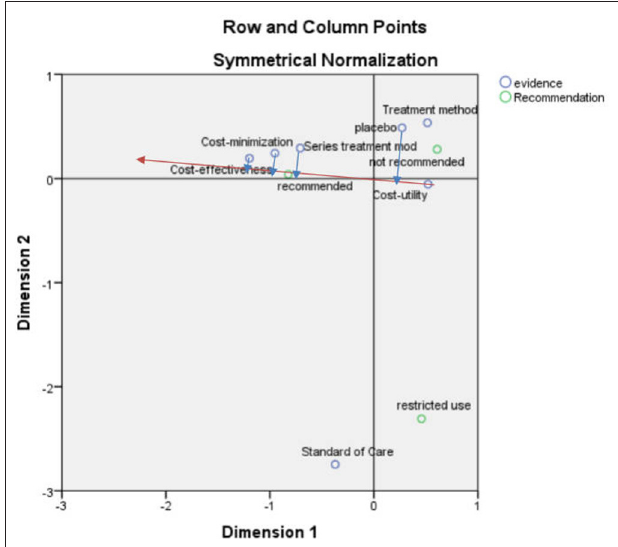
FIGURE 4 | Correspondence analysis biplot (recommended scenarios and economic